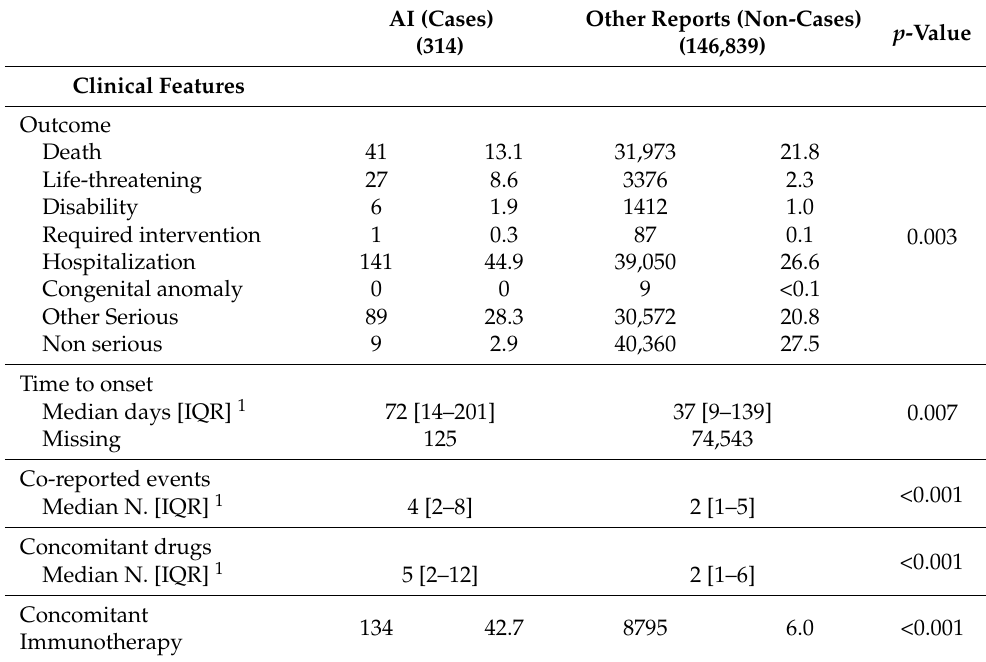
Table 2. Clinical data on adrenal insufficiency (AI) with